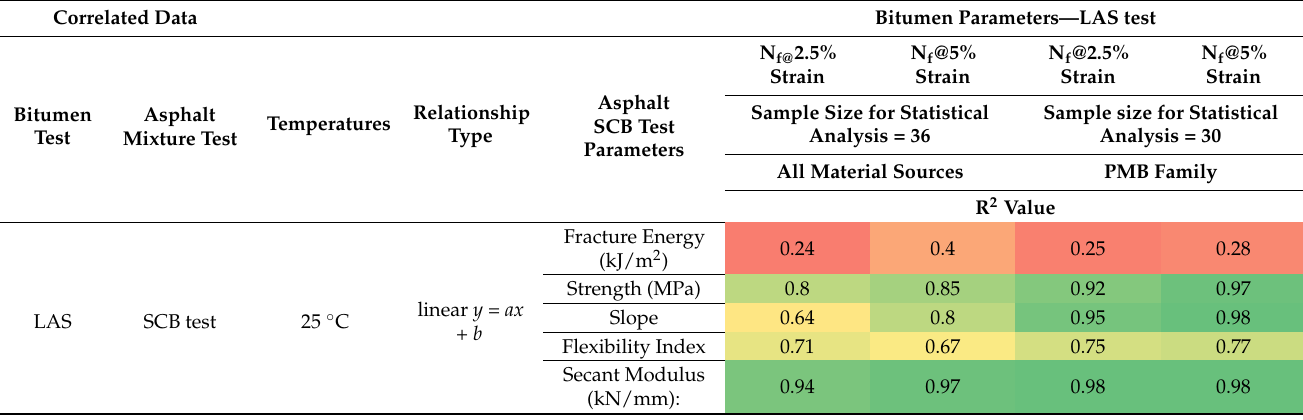
Table 9. Pearson coefficients of determinations between binders’ LAS and asphalt mixtures’ SCB tests; (Green Background = Moderate to High Correlation (Darker Green = Higher Correlation Compared to Lighter Green); Yellow Backgound = Average Correlation; Red Background = Poor Correlation).